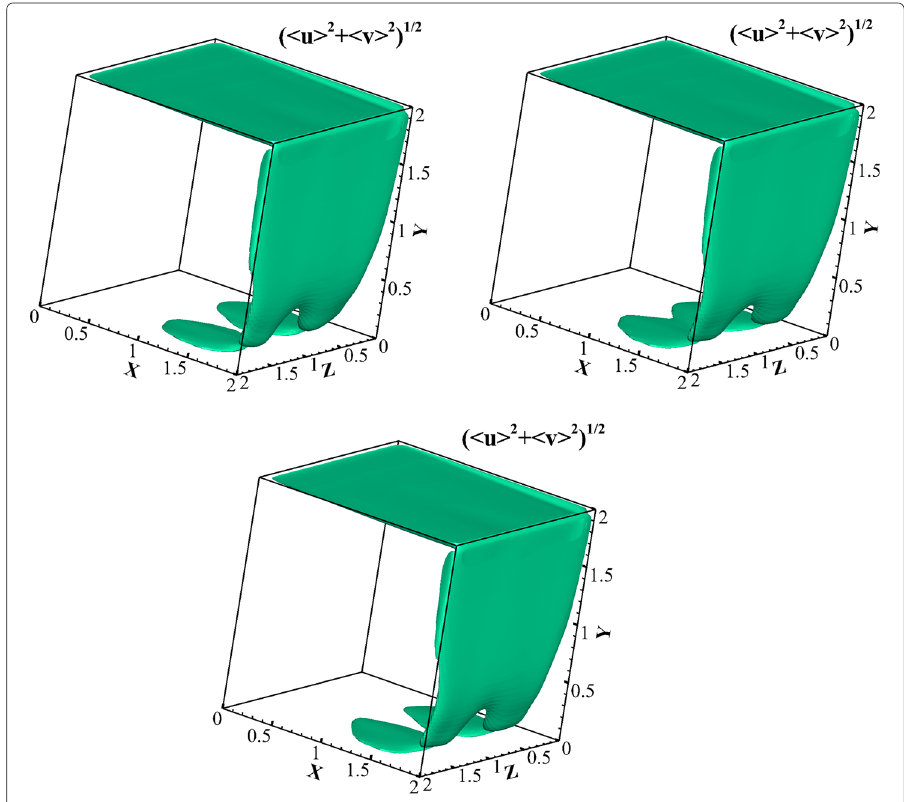
" (cid:12) u (cid:13) 2 + (cid:12) v (cid:13) 2 . a No SGS model, b Vreman model, c WALE model Fig. 18 The contour surface of